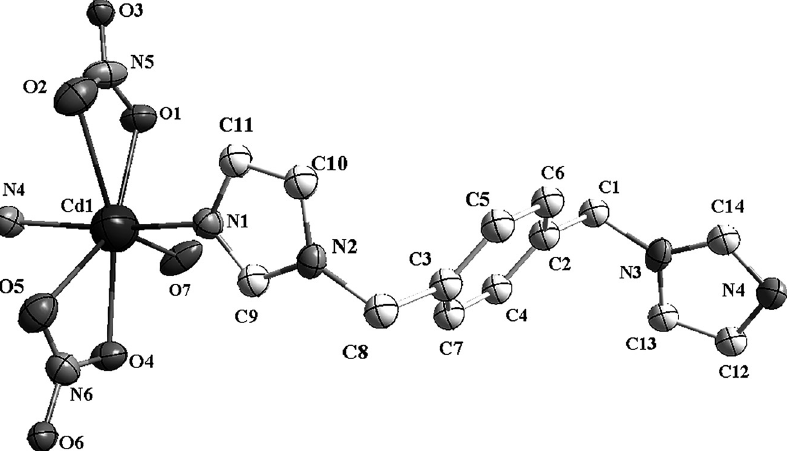
Table  : Data collection and